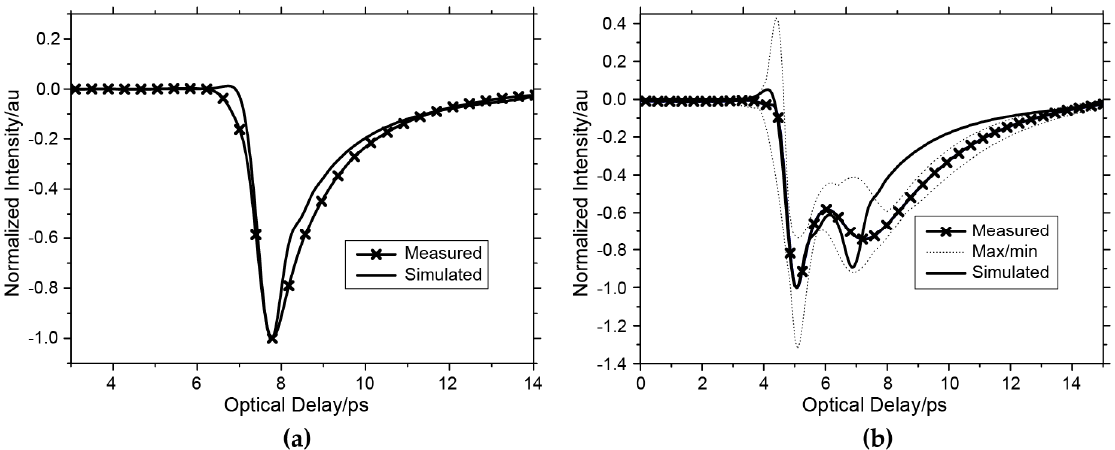
Figure 2. Comparison of measured and simulated impulse functions of the ( a ) (volar) forearm and ( b ) the palm. Reprinted with permission from ref. [29]. Copyright 2004 Physics in Medicine and Biology .